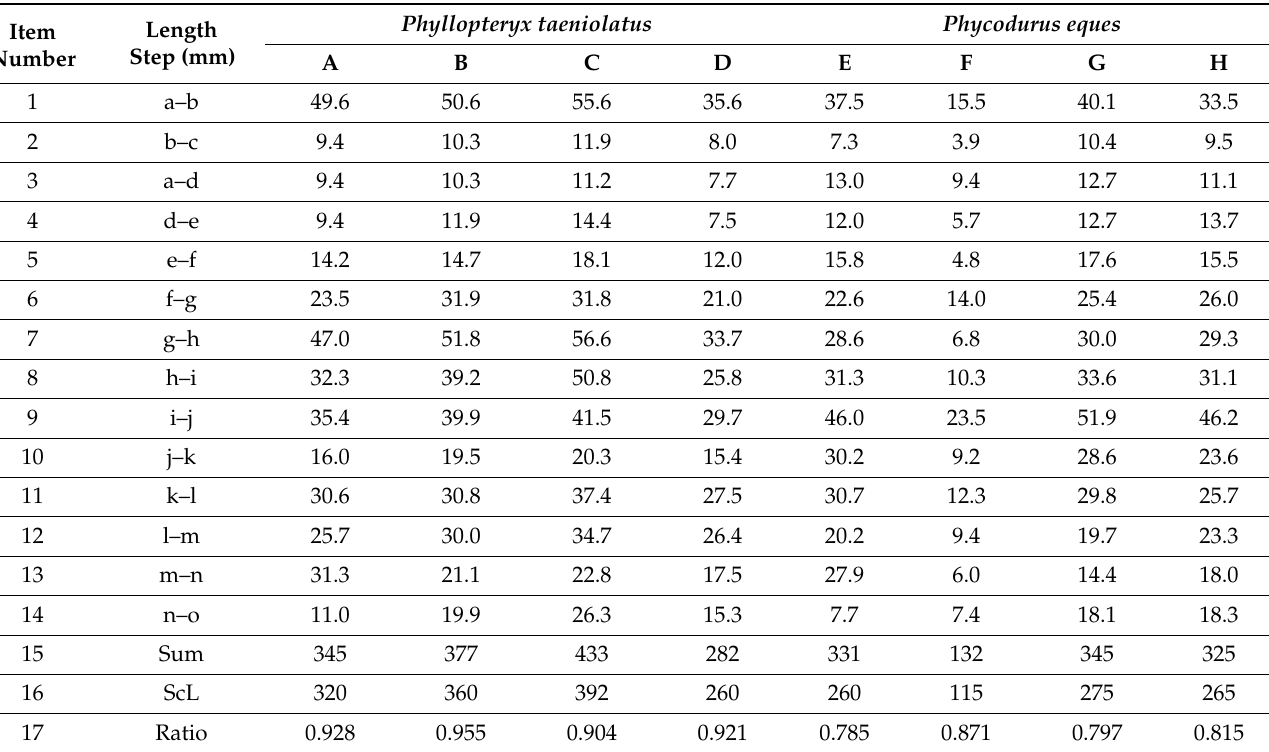
Table 3. Data for computing the ratio of two different ‘length types’ in two species of